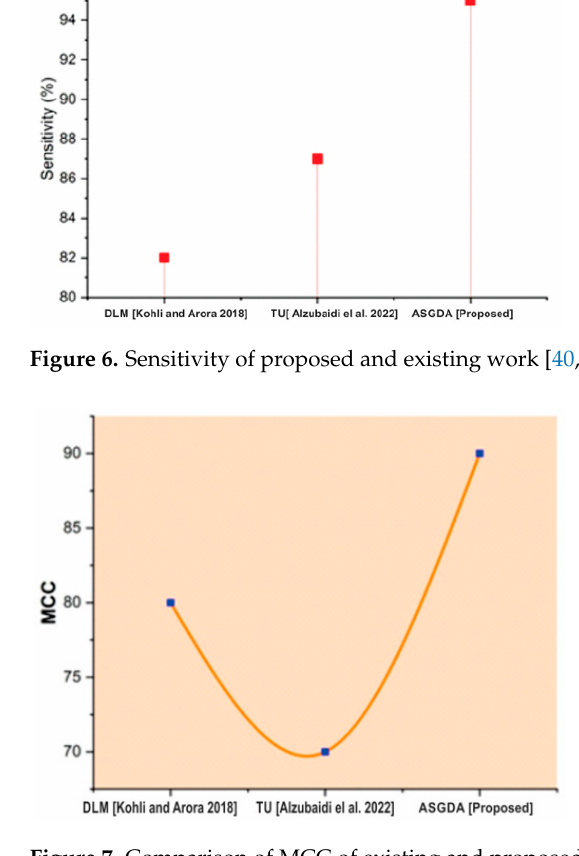
Figure 8. Comparison of accuracy with the traditional and proposed method [42,43].